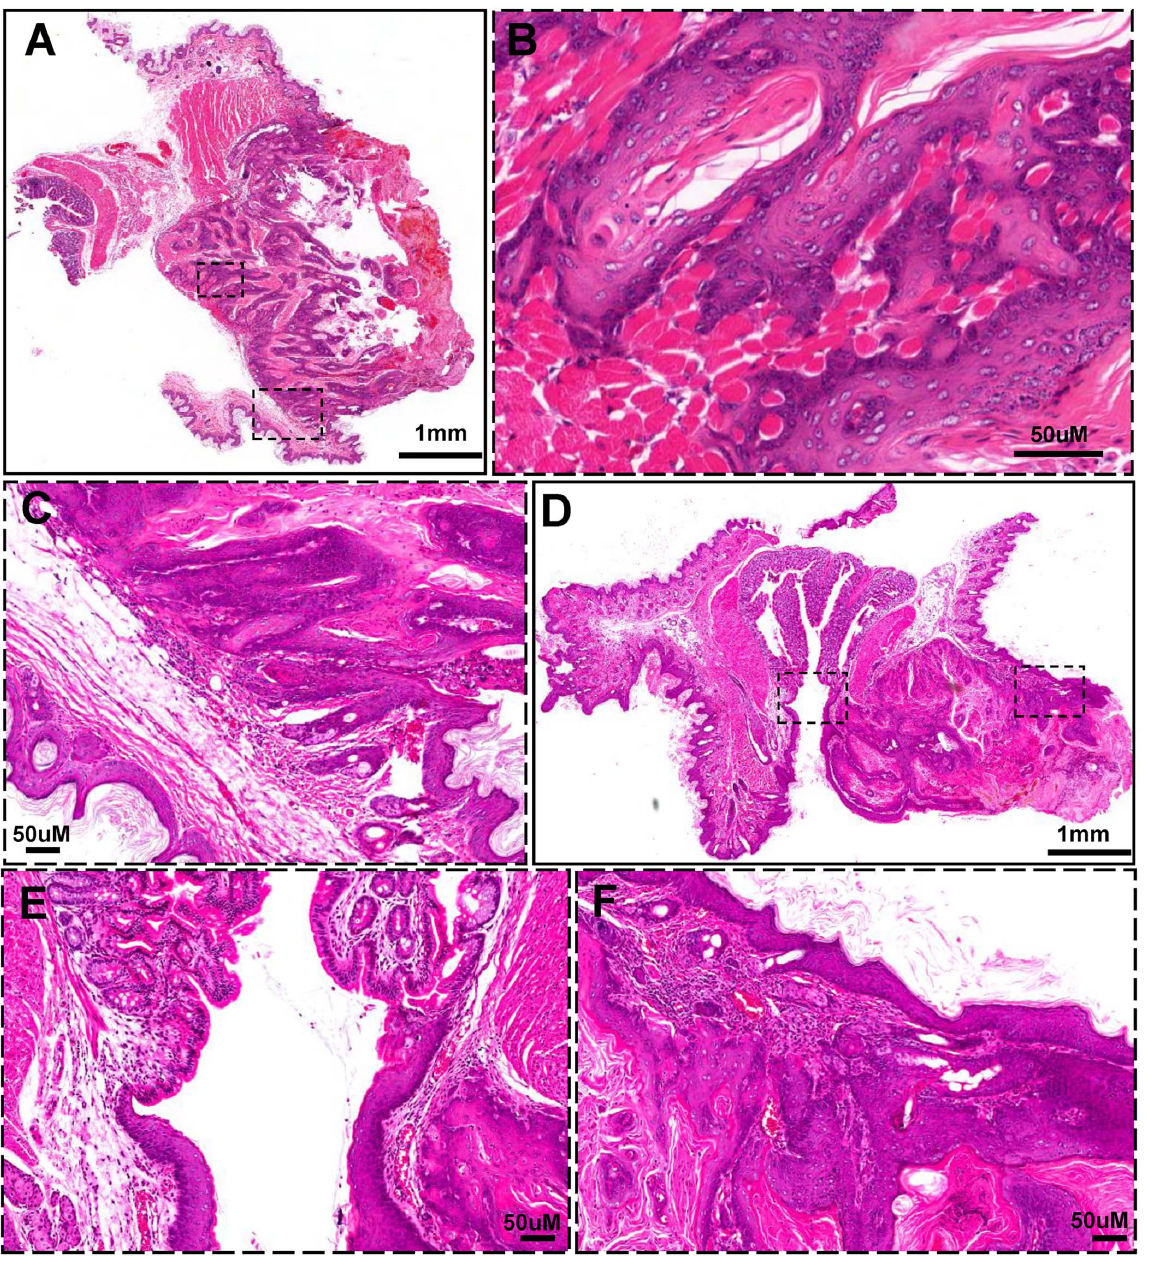
Figure 2. Histological feature of ASCC in Tgfbr1/Pten 2cKO mice. (A), Representative saggital sections of ASCC tumors showing differentiated epithelial cells that grew as solid sheets or nests. Invasion of ASCC into surrounding tissue (B) and origination of ASCC (C). Coronal section of ASCC showing ASCC tumor in squamous epithelial (D) but not in columnar epithelial cells (E, F). (Hematoxylin and eosin staining).